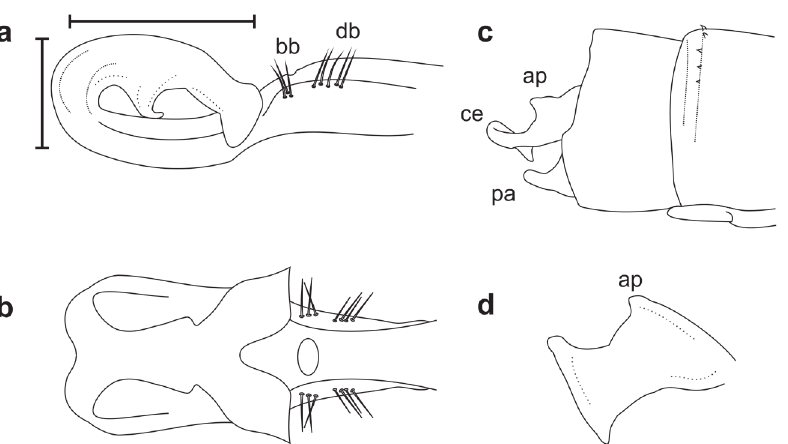
Figure 2. Negragrion sagma